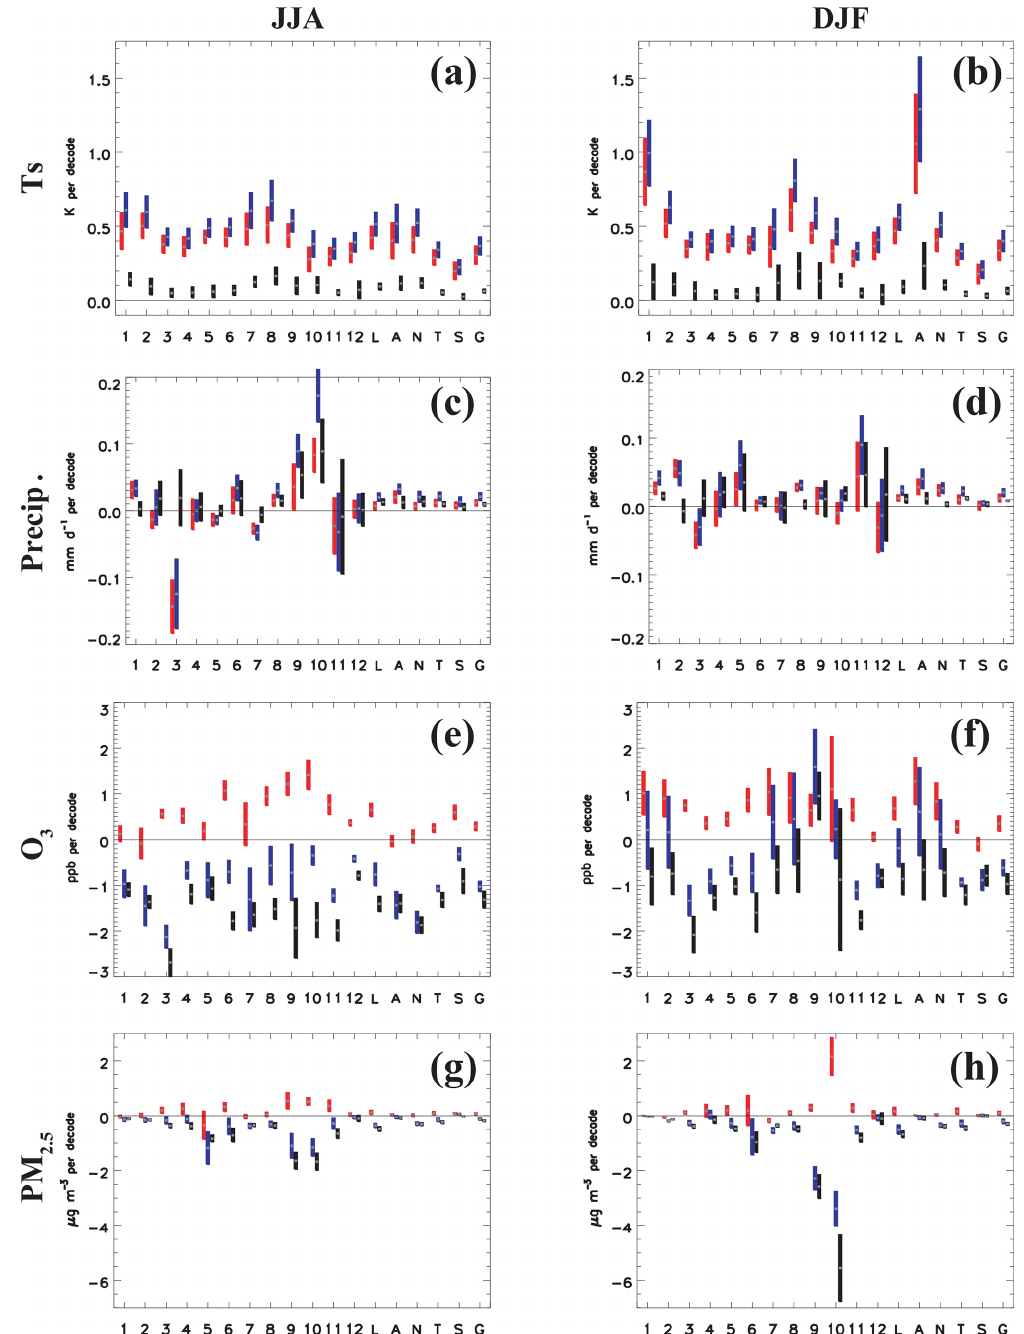
Figure 7. Regional climate and air pollution seasonal responses to NTCF mitigation. Bar plots show regional 2015–2055 June–July–August (JJA; left panels) and December–January–February (DJF; right panels) trends in (a–b) surface temperature ( T s ); (c–d) precipitation (Precip); (e–f) surface ozone (O 3 ); and (g–h) surface particulate matter (PM 2 . 5 ) for weak (red) and strong (blue) air quality control, and NTCF mitigation (black). Bar center (gray horizontal line) shows the multi-model mean trend, estimated as the average of each model’s mean trend. √ n , where σ is the standard deviation of the individual model mean Bar length represents the 95% confidence interval, estimated as 2 σ/ trends and n is the number of models. World regions are identical to those in Figure 5. Trend units are Kdecade − 1 for T s ; mmd − 1 decade − 1 for Precip; µgm − 3 decade − 1 for PM 2 . 5 ; and ppbdecade − 1 for O 3